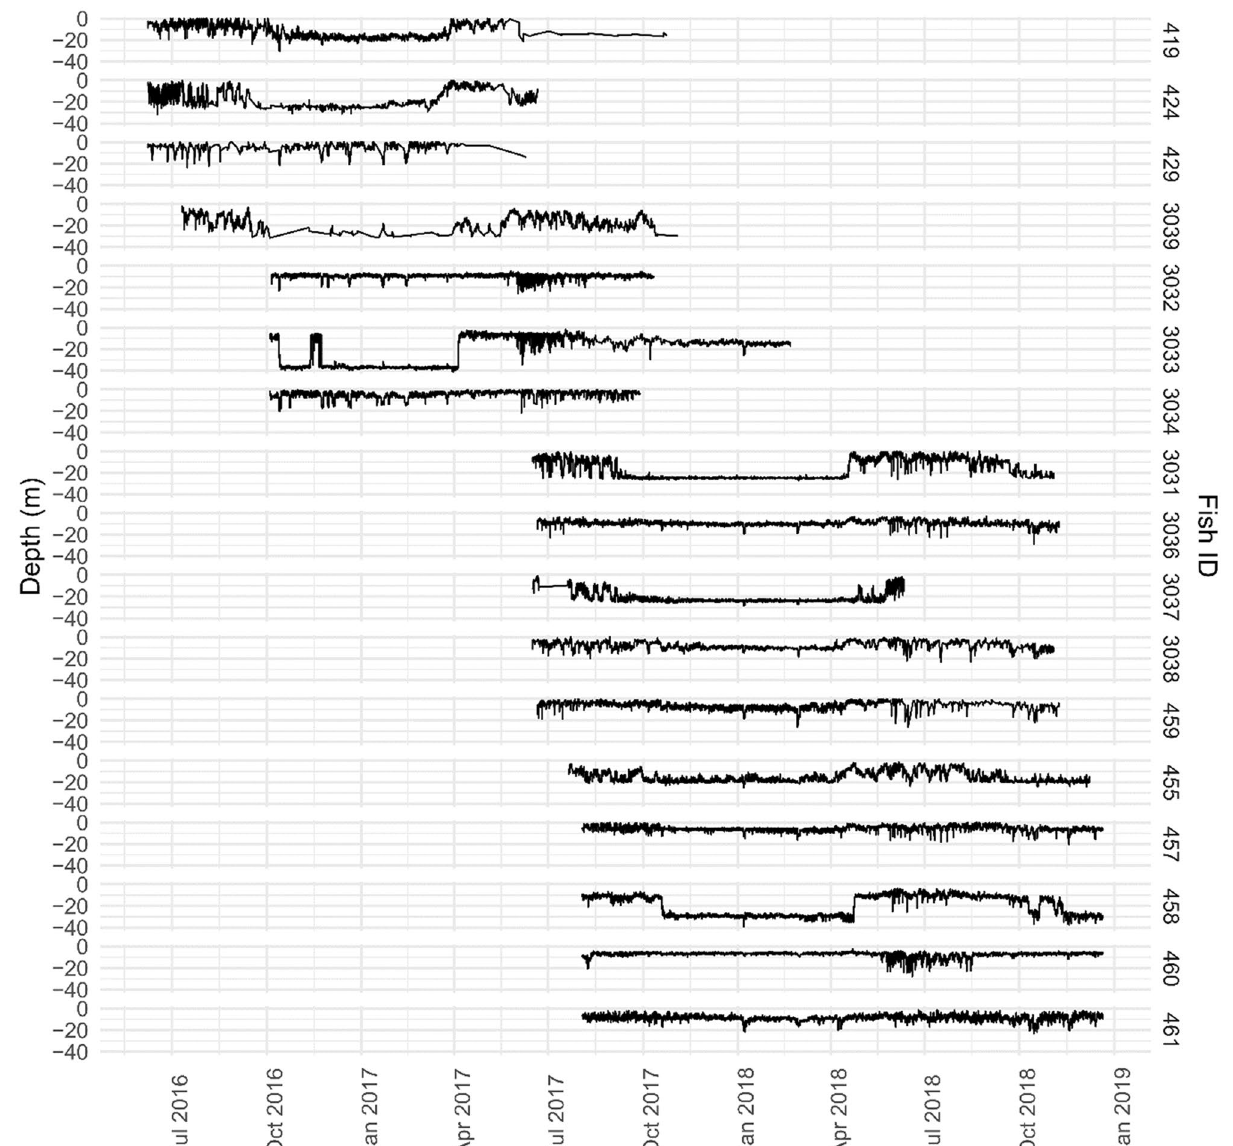
Figure 2. Individual depth during the study period. Mean depth per hour of each fish ID (identification number) over